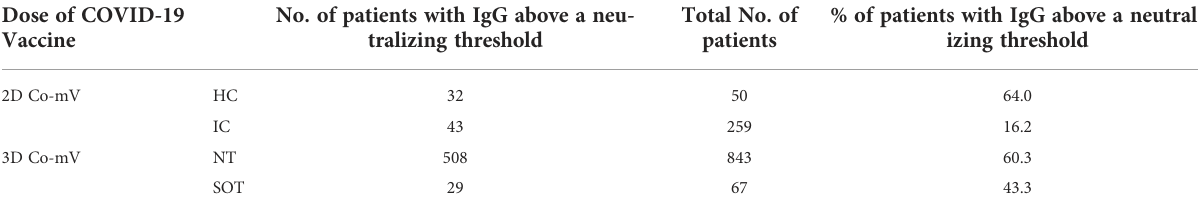
TABLE 2B Estimation of 2D and 3D COVID-19 vaccine administered IC cohorts exhibiting IgG titer above a neutralizing threshold of 4160 AU/mL (41). Dose of COVID-19 Vaccine